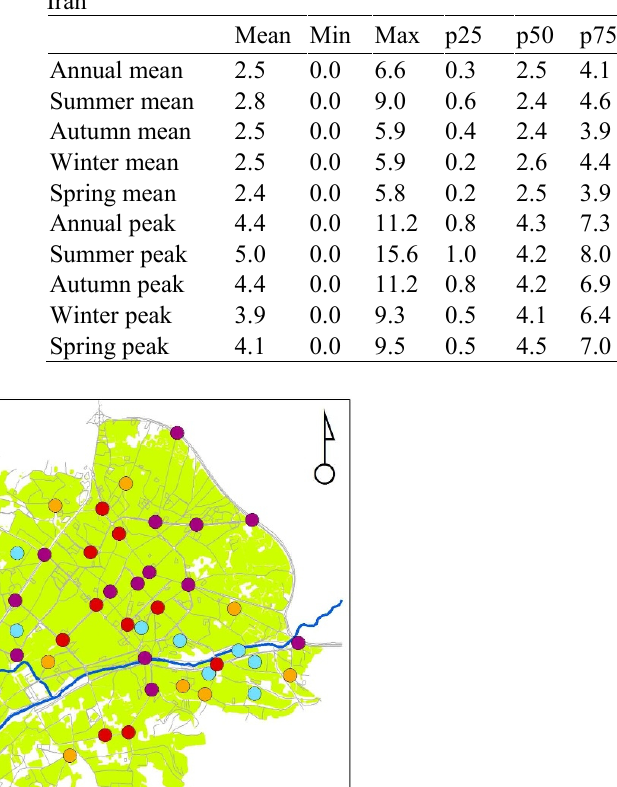
Table 1. Summary statistics of measured carbon monoxide concentrations (ppm) in ambient air of Urmia,